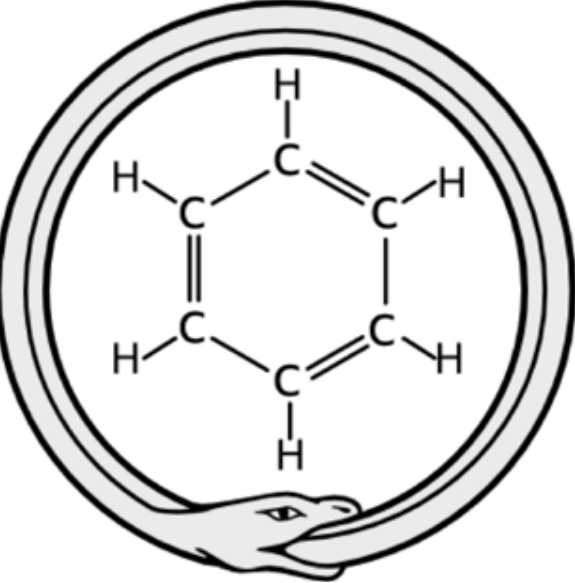
Figure 4. The cyclic molecular structure of benzene and the ourob- oros eating its own tail. Image credit: Haltopub / CC